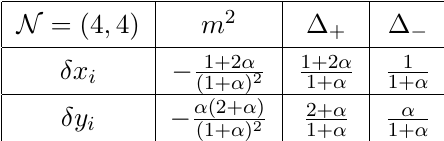
Table 1. Mass and conformal dimensions of scalar fluctuations for the N = (4 , 4)